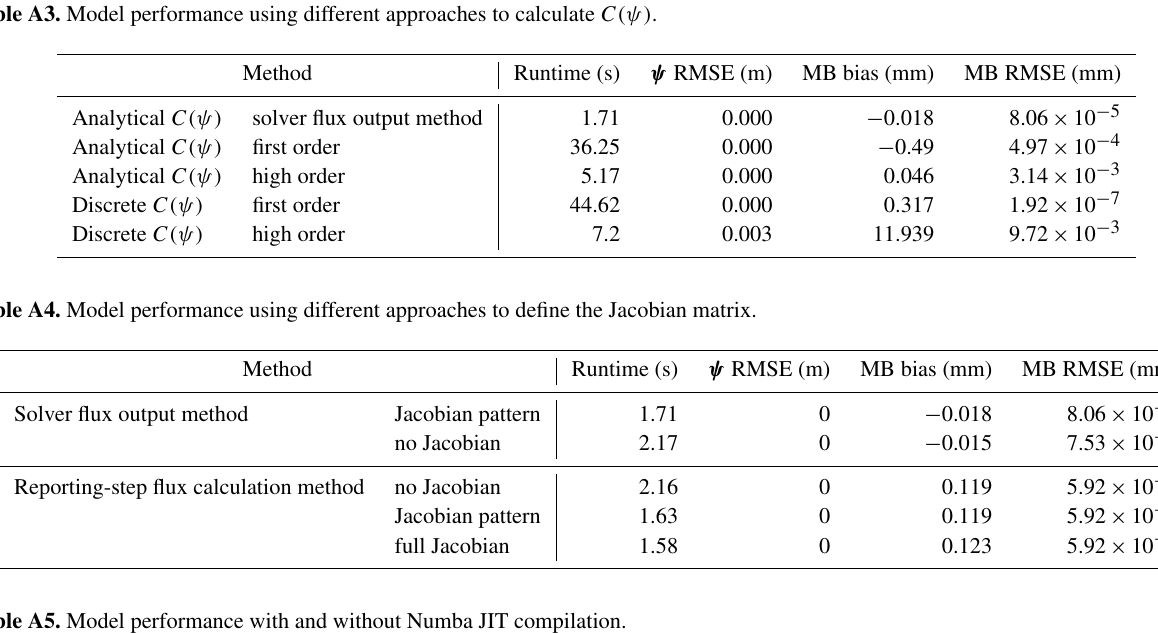
Table A5. Model performance with and without Numba JIT